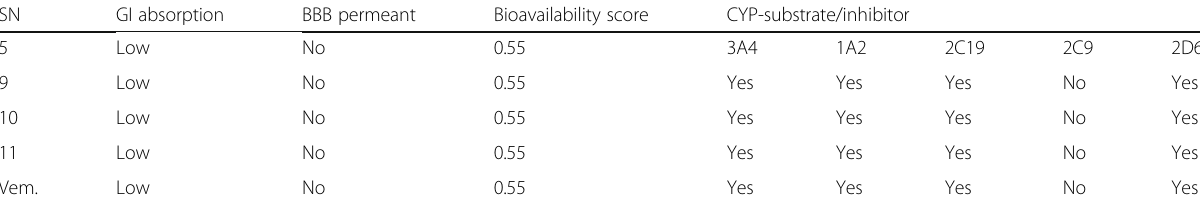
Table 4 Predicted ADMET properties of the selected compounds SN GI absorption BBB permeant Bioavailability